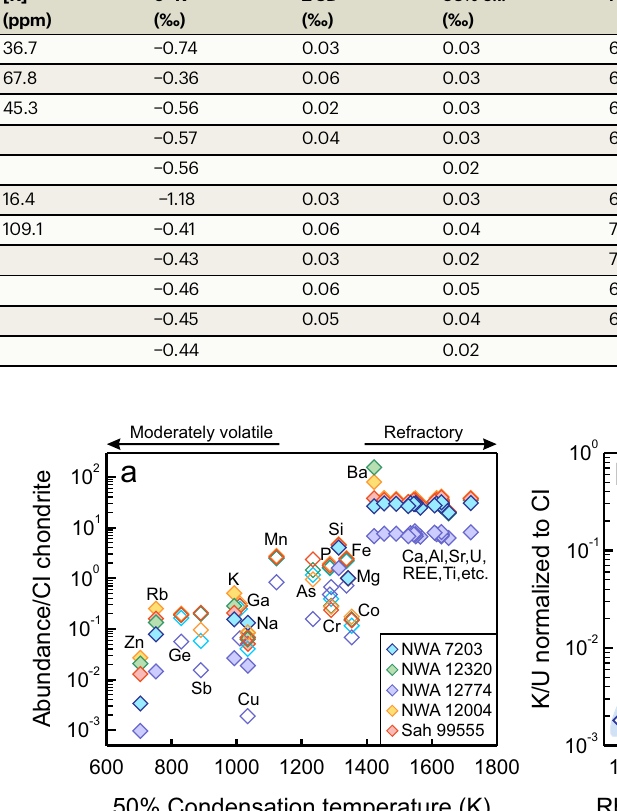
Table 2 | Potassium concentrations and isotopic compositions of angrites analyzed in this study Sample